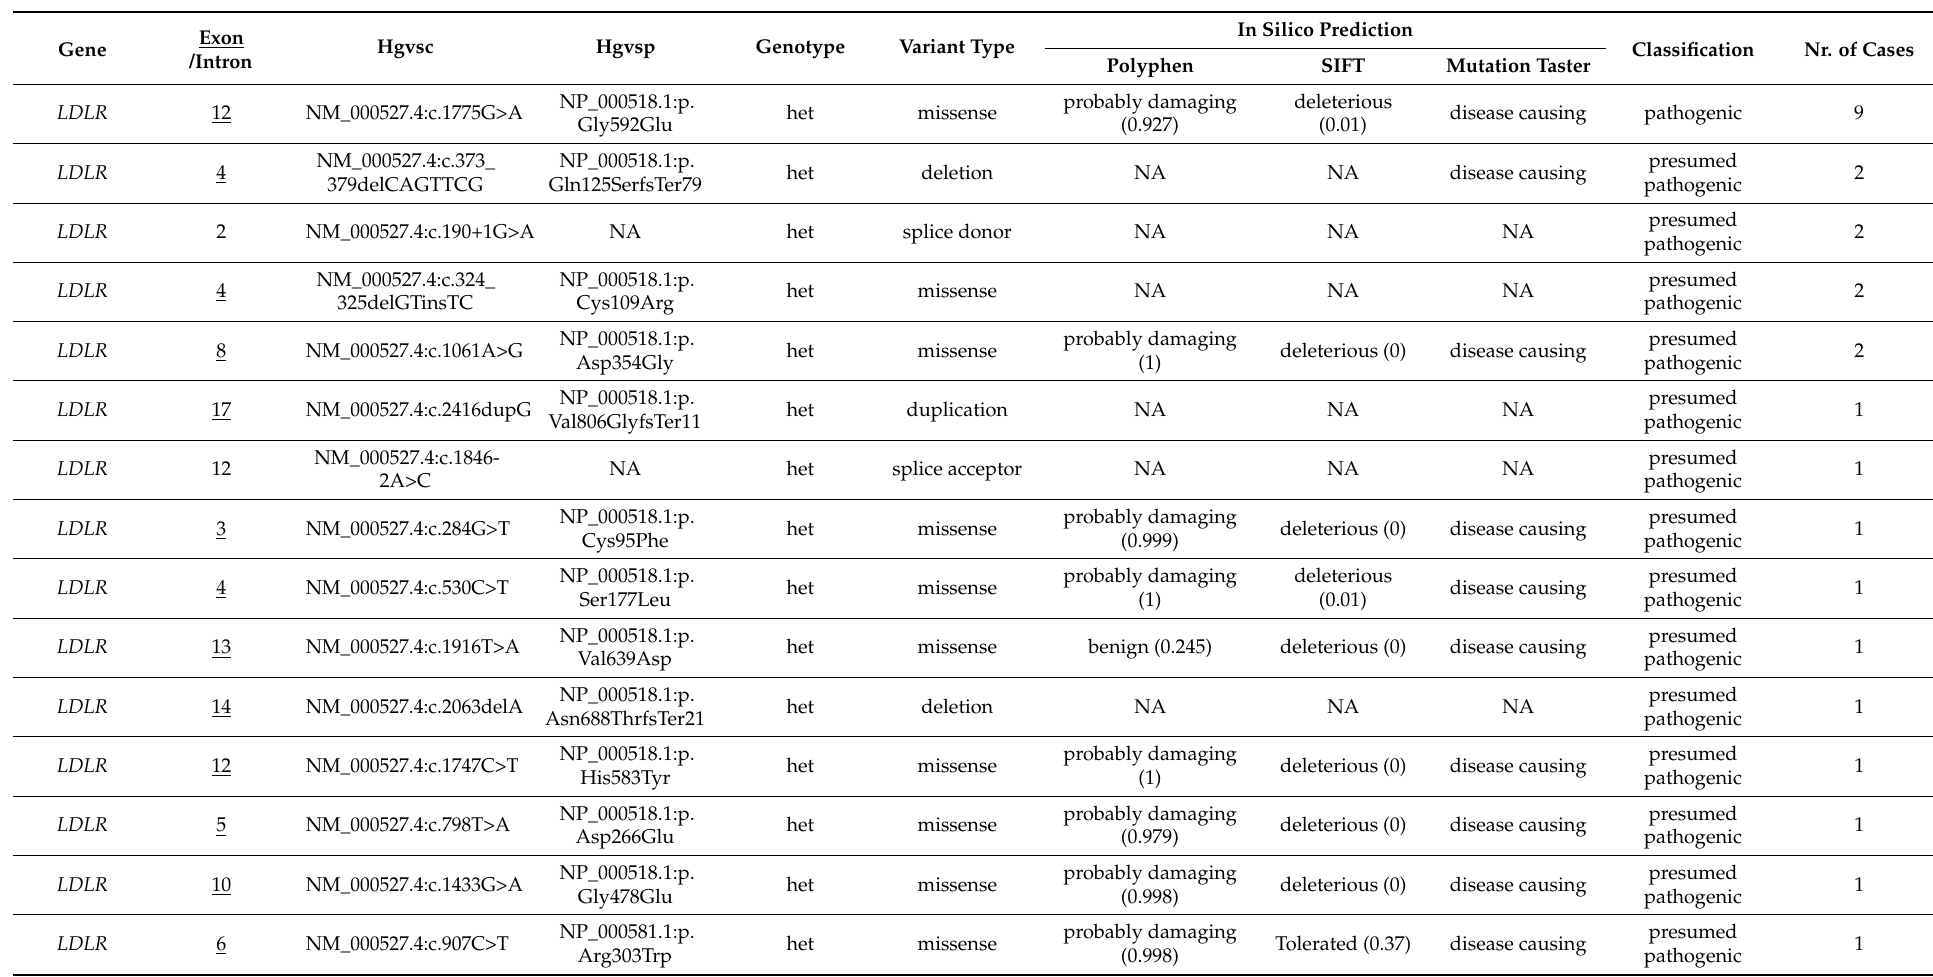
Table 3. The variant table for selected aberrations identified by NGS sequencing, including the name of the affected gene with exon (indicated in underline)/intron localization, HGVSc and HGVSp description, genotype, variant type, in silico predictions, initial classification and number of the identified